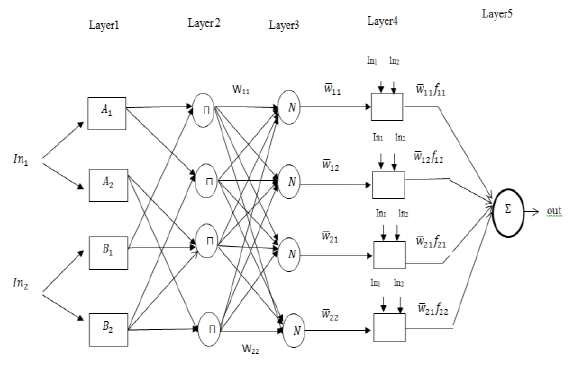
Figure 1. A typical ANFIS architecture for a two-input Sugeno model with four